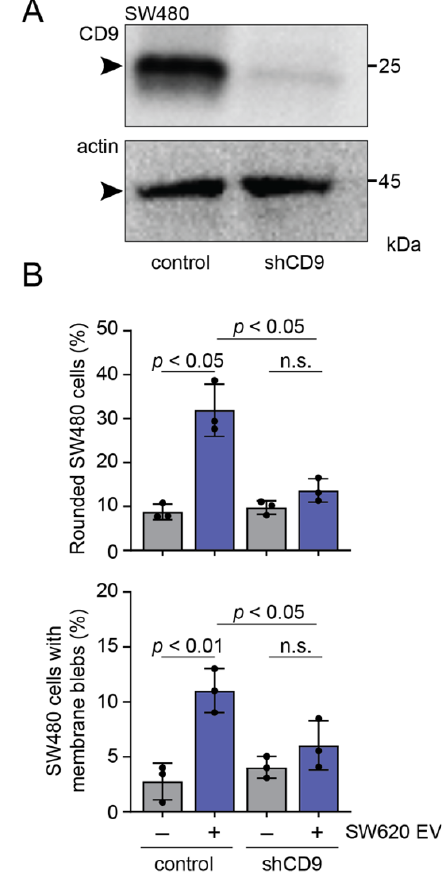
Figure 6. The lack of CD9 in SW480 cells impedes pro-metastatic morphological alterations produced by SW620 cell-derived EVs. ( A ) Parental (control) or CD9-knockdown (shCD9) SW480 cells were analyzed by immunoblotting for CD9 and β -actin. Molecular mass markers (kDa) are indicated. Arrowhead indicates the protein of interest. ( B ) SW480 cells as indicated were incubated with (+) SW620 cell-derived EVs (1 × 10 9 particles) or without (–) for 5 h. Afterward, fixed cells were stained with DAPI and fluorochrome-conjugated phalloidin to label nuclei and actin filaments, respectively, before observation by CLSM. The percentage of cells with rounded morphology (top panel) or membrane blebs (bottom panel) was quantified. Means ± S.D. and individual values for each experiment are shown ( n = 3). At least 100 cells were evaluated for each experiment. p values are indicated. n.s., not significant.